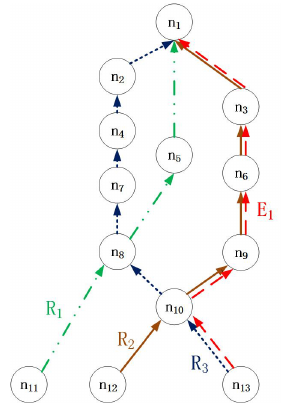
Figure 4. An example of indirect routing.